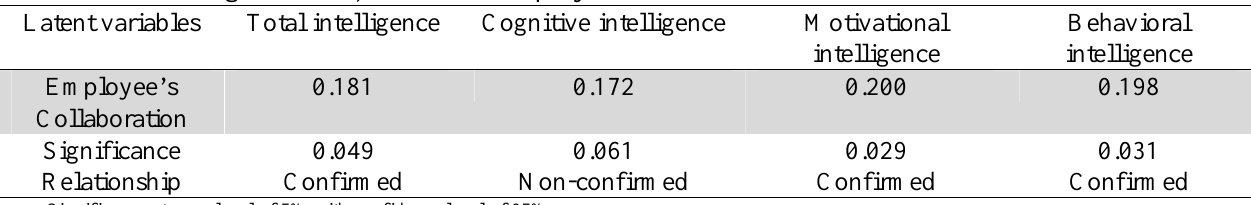
Correlation between cultural intelligence of managers and employee’s collaboration (Number of managers = 119, number of employees = 175)